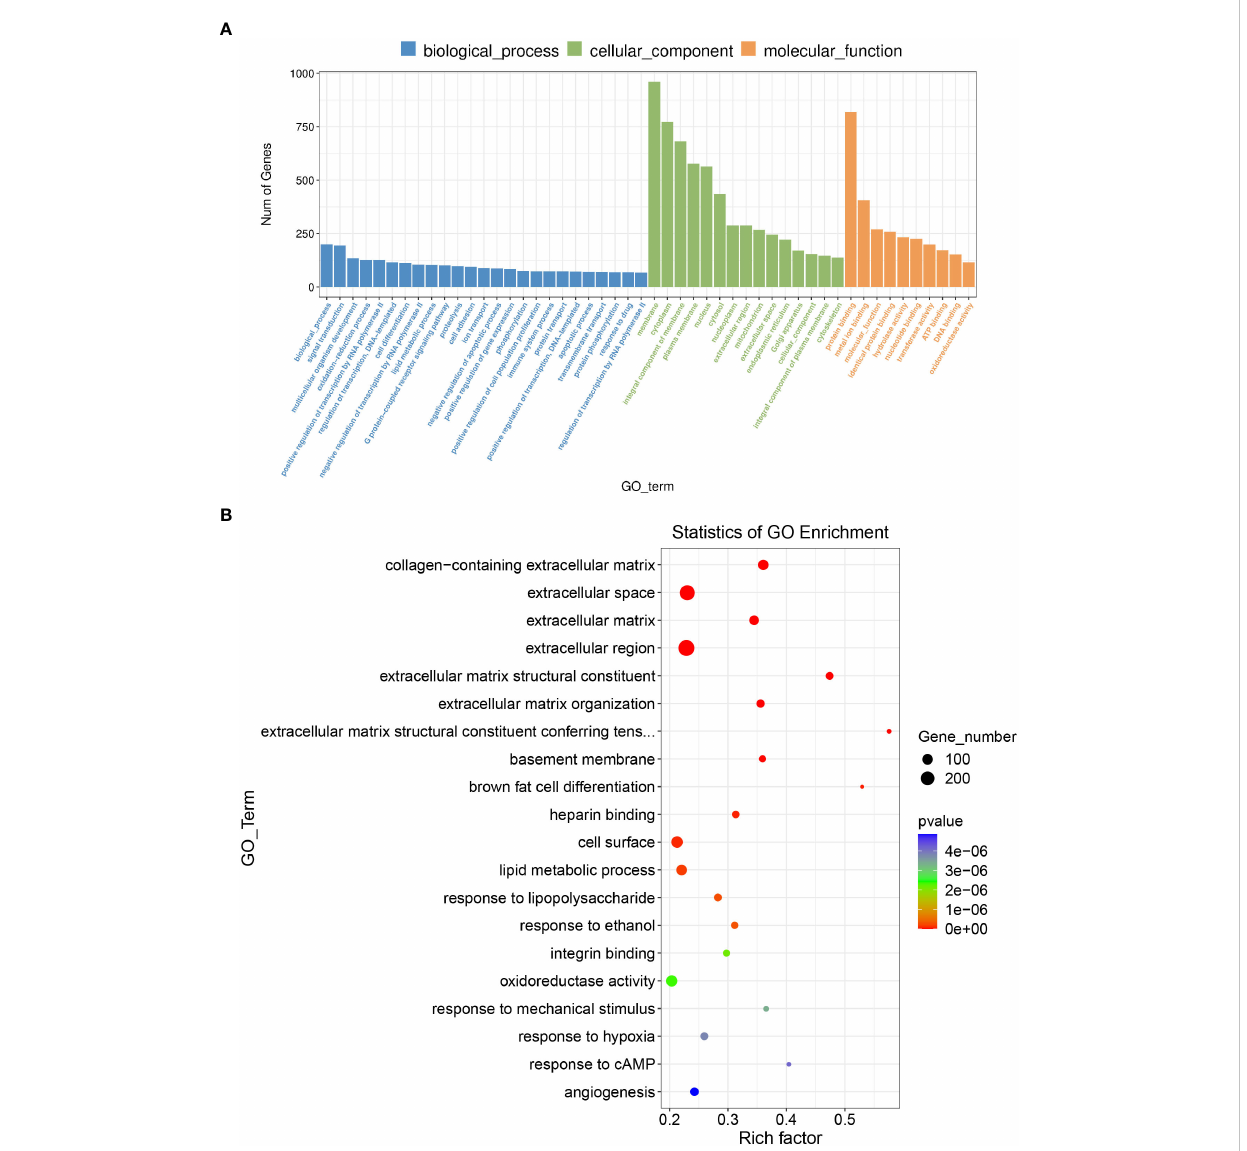
FIGURE 5 GO enrichment analysis for the DEmRNAs with the 10 highest enrichment scores. (A) GO enrichment analysis for co-expressed DEmRNAs of DElncRNAs. Blue bars are biological processes, green bars are cellular components, and yellow bars are molecular functions. (B) The size of the spot indicates the gene numbers enriched in the pathway, and the color of the spot indicates the signi fi cance level of the enriched